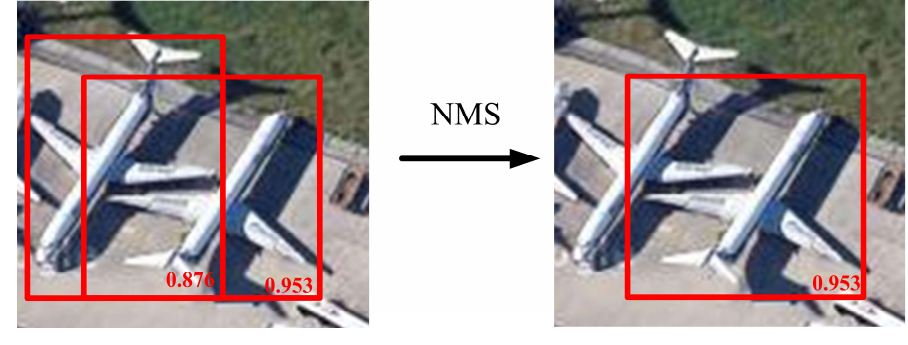
Figure 9. The missed results.